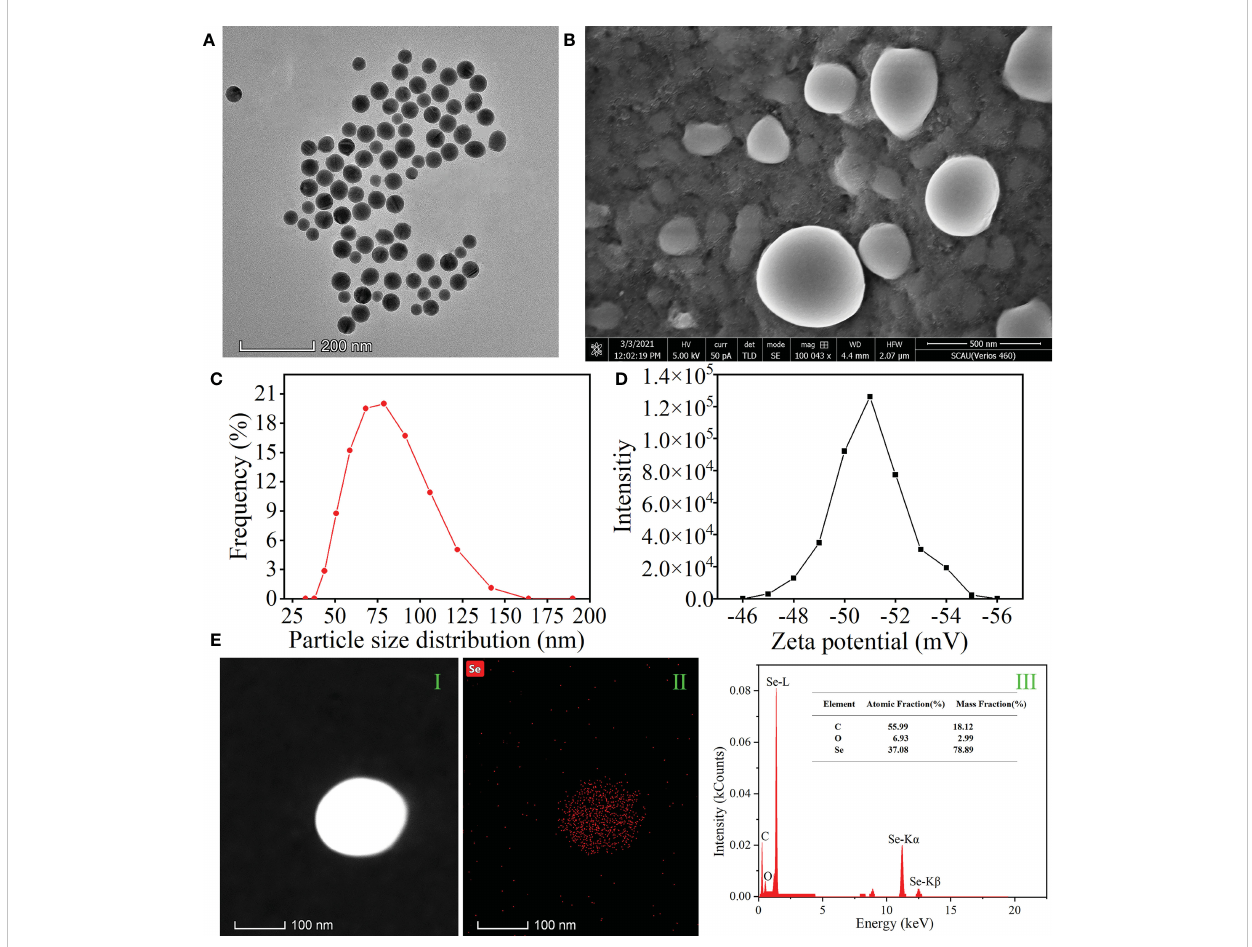
FIGURE 1 Characterization of algal polysaccharides – selenium nanoparticles (APS-SeNPs). (A) Transmission electron microscopy (TEM) images. (B) Scanning electron microscopy (SEM) images. (C) Particle size distribution. (D) Zeta potential. (E) TEM/energy-dispersive X-ray spectroscopy [HAADF-TEM (I), X- ray fl uorescence image of Se (II), and TEM-EDS (III)].